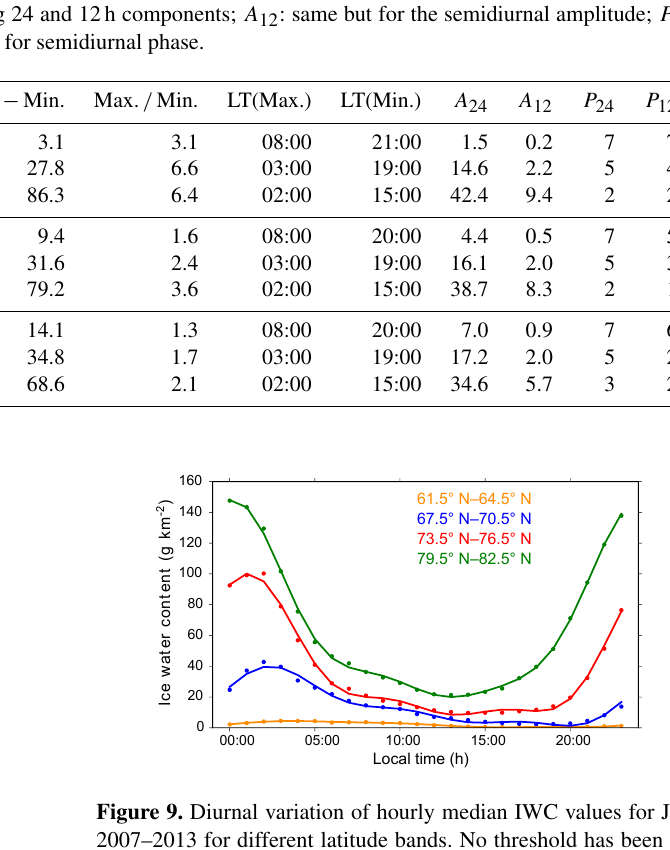
Table 5. Climatology of local time variations of IWC in units of grams per square kilometer (gkm − 2 ) for three thresholds (IWC > 0, IWC > 10, and IWC > 40) at different latitude bands for the period July 1979–2013. Mean: mean daily IWC over a daily cycle; Max.: maximum IWC over a daily cycle; Min.: minimum IWC over a daily cycle; Max. − Min.: difference between maximum and minimum IWC; Max. / Min.: ratio between maximum and minimum IWC; LT(Max.): local time (LT) in hours of Max.; LT(Min.): local time (LT) in hours